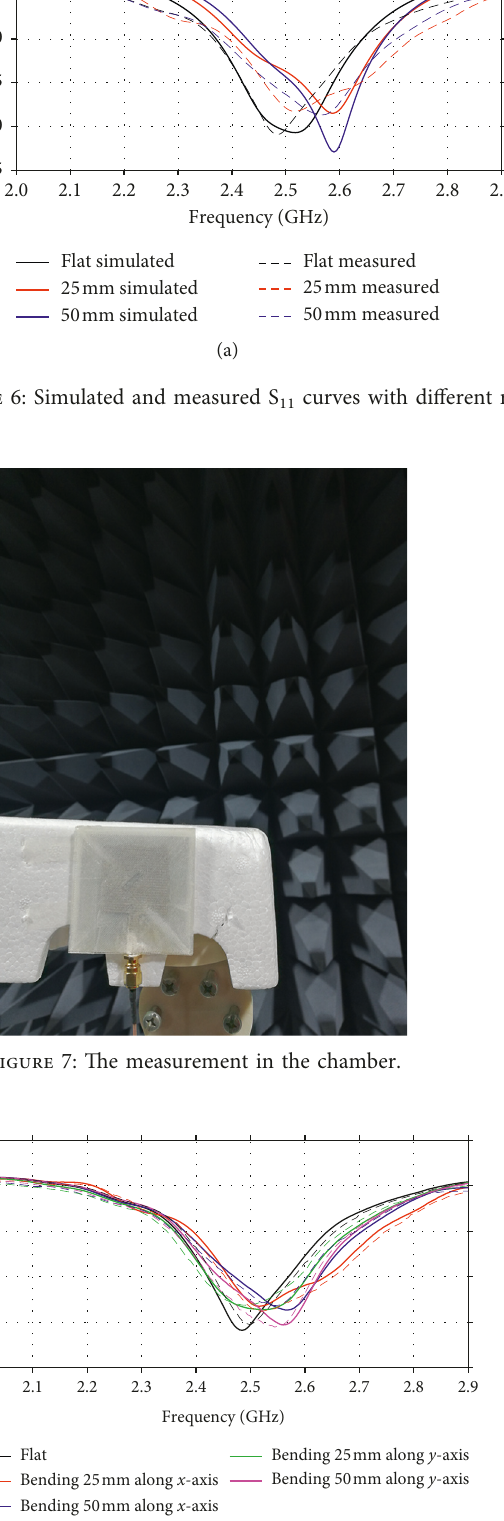
Figure 8: Measured S 11 in free space (solid curves) and on the human body (dashed curves).